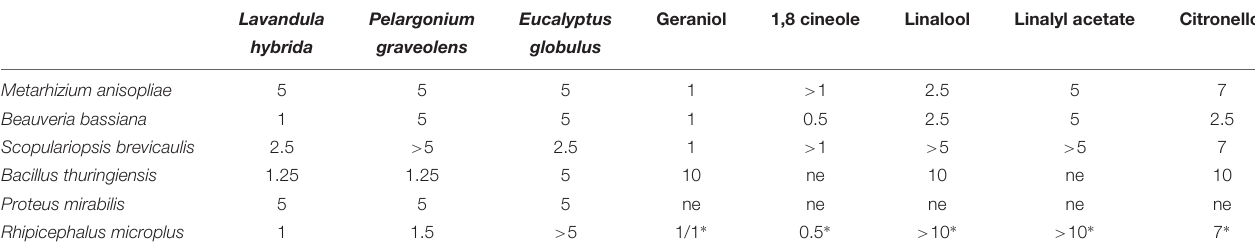
TABLE 2 | Biological activities of selected essential oils and components against fungi, bacteria and ticks tested in the study. Lavandula